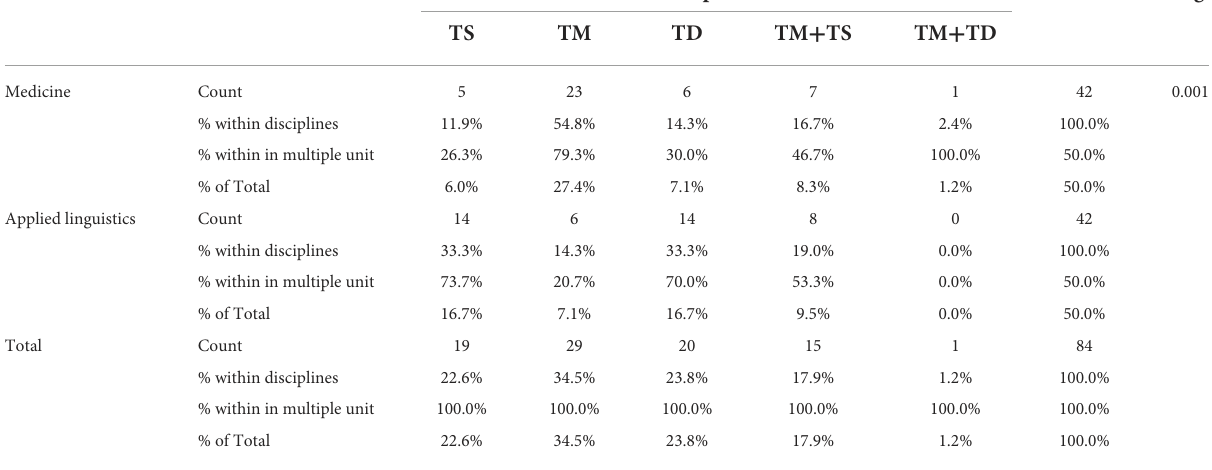
TABLE 7 Rhetorical combinations in multi-unit titles in the two disciplines (chi-square